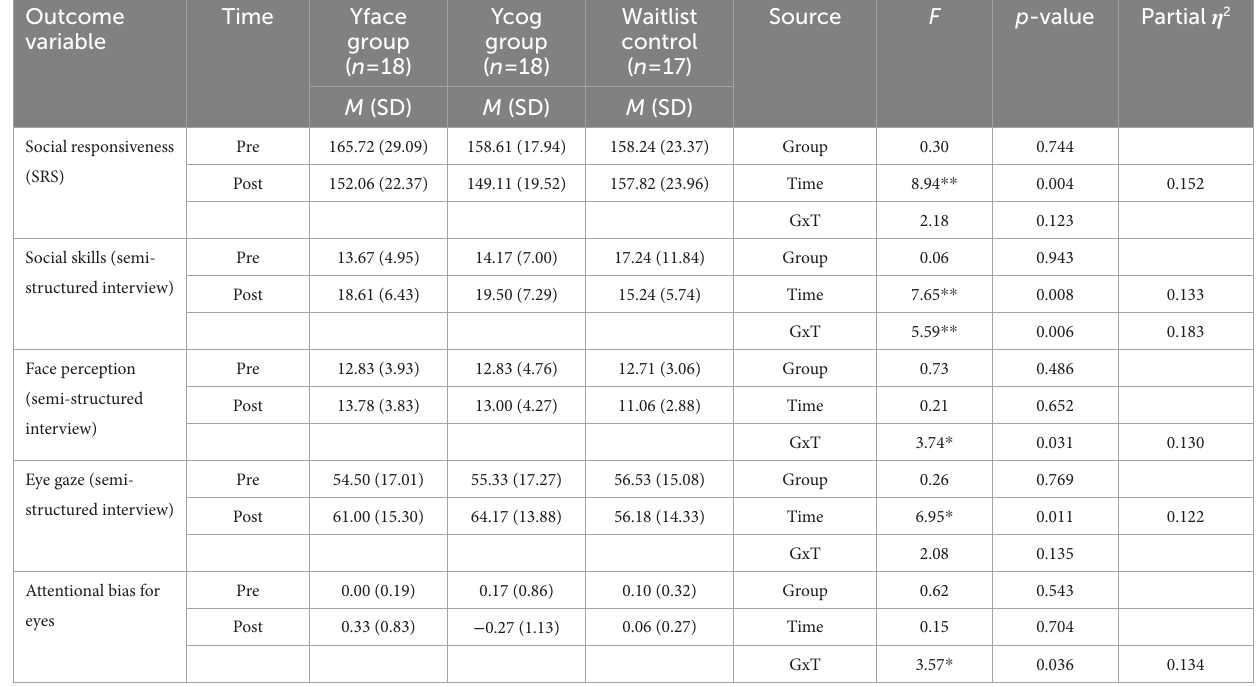
TABLE 4 Repeated-measures ANOVA for pre- and post-intervention scores for each outcome variable by group. Outcome variable